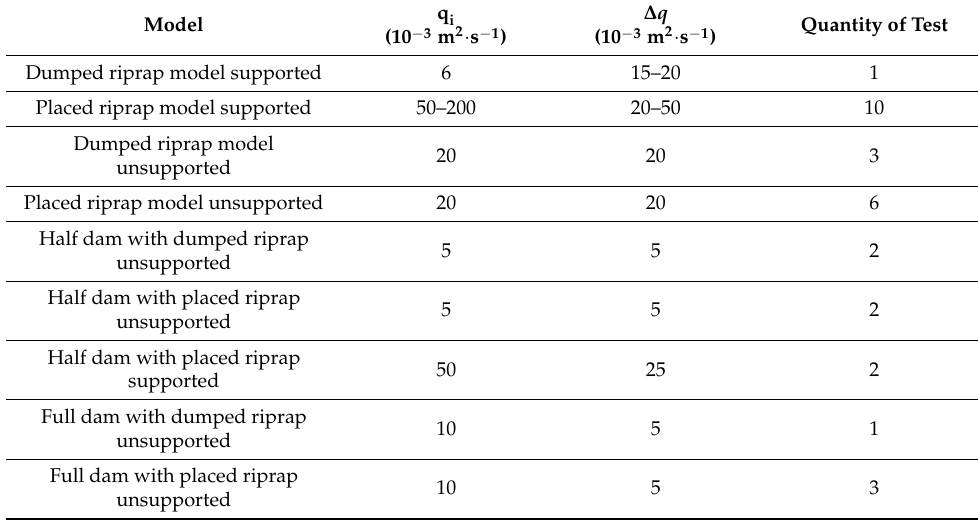
Table 1. Initial discharge (q i ), discharge increment ( ∆ q ), and quantity of test for each experimental